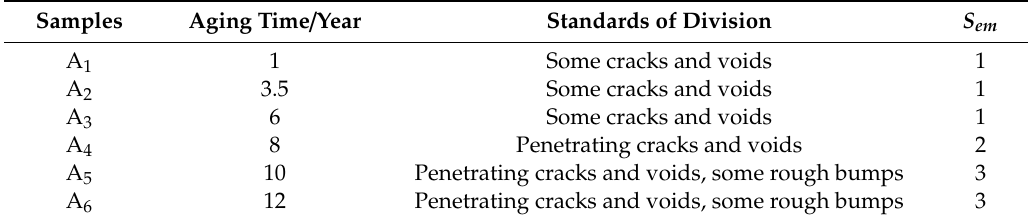
Table 3. Aging level of composite insulators of Factory